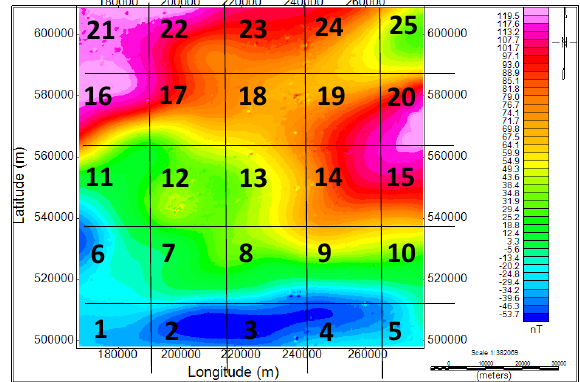
Figure 7: Twenty-five spectral blocks for estimation of the depth to